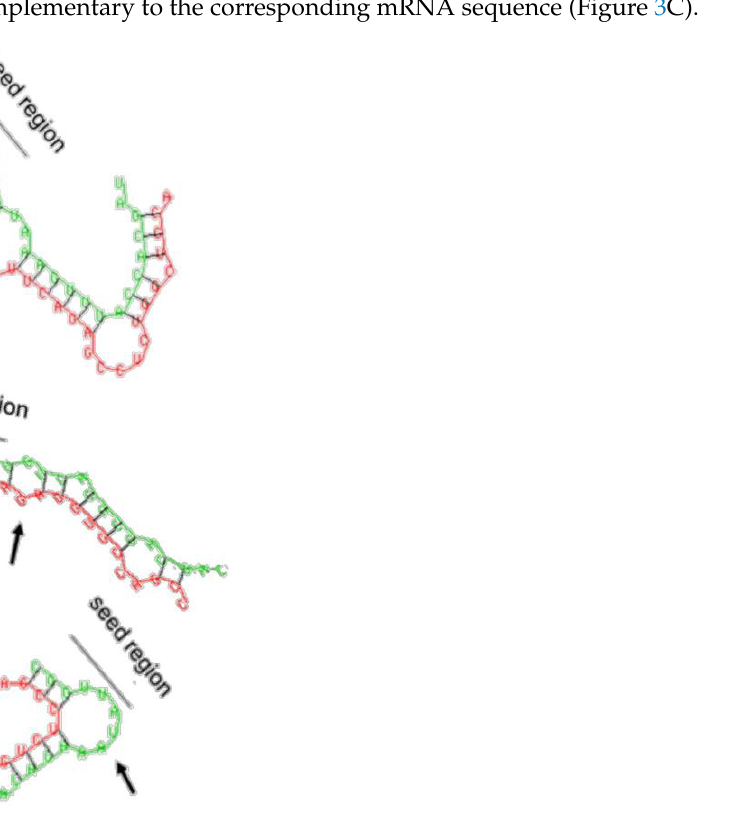
Figure 3. Structural in silico analysis of the miRNA/target mRNA interaction. Computational models of miRNA/mRNA interaction between ( A ) miR-29b, ( B ) miR-497, and ( C ) miR-195, respectively, with a corresponding sequence in the 3 ′ UTR of CPXM2 mRNA. (green) miRNA; (red) CPXM2 mRNA 3 ′ UTR sequence; (seed region) miRNA nucleotides 2 – 8; (arrow) central bulge.